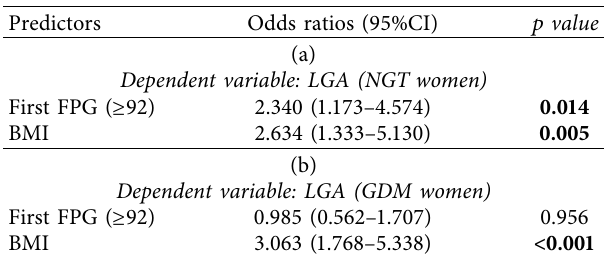
Table 3: Multivariate analysis to identify predictors of LGA in